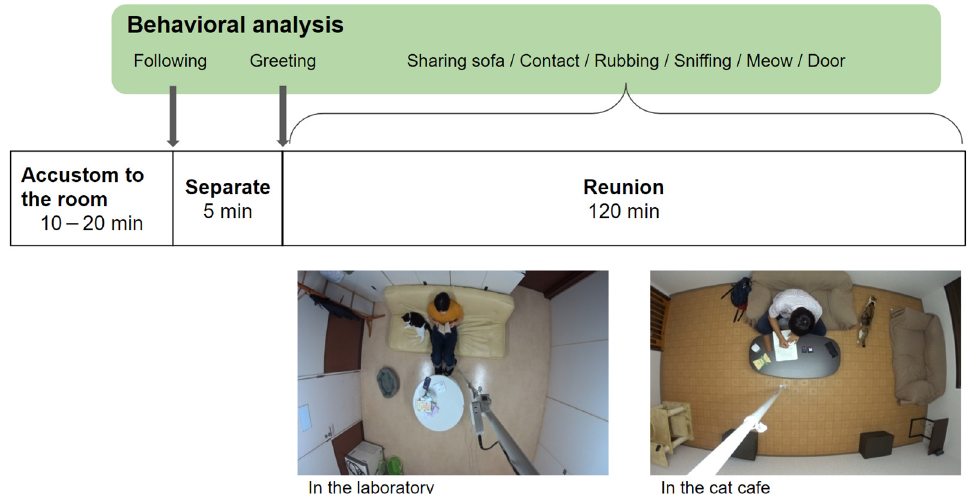
Figure 1. Experimental procedure.